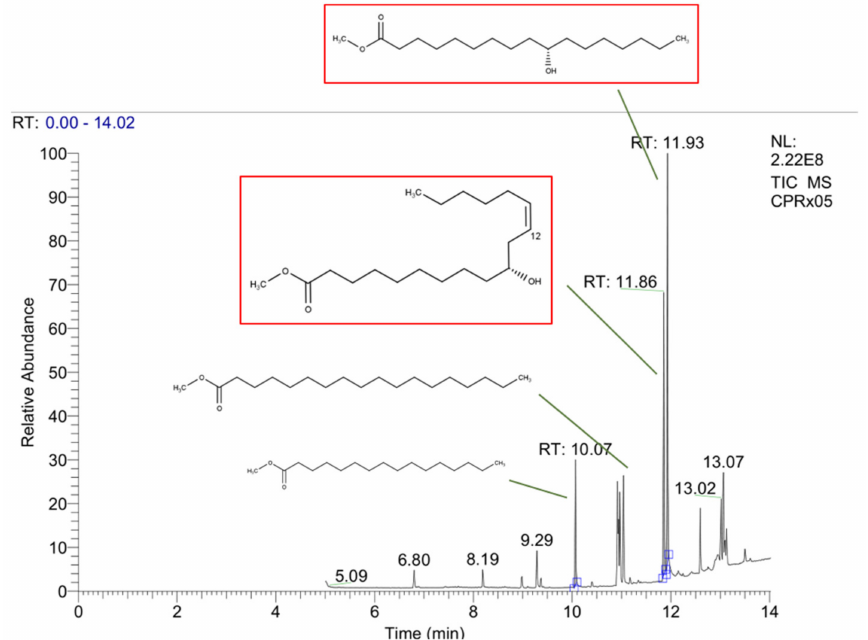
Figure 4. Biocatalyzed hydration of the unsaturated fatty acids oleic acid and linoleic acid in Cp extracts catalyzed by the oleate hydratase